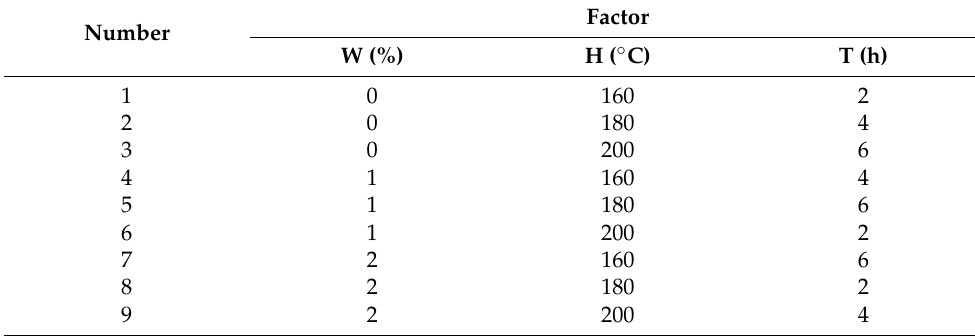
Table 1. Orthogonal test of dipping high-temperature treatment.